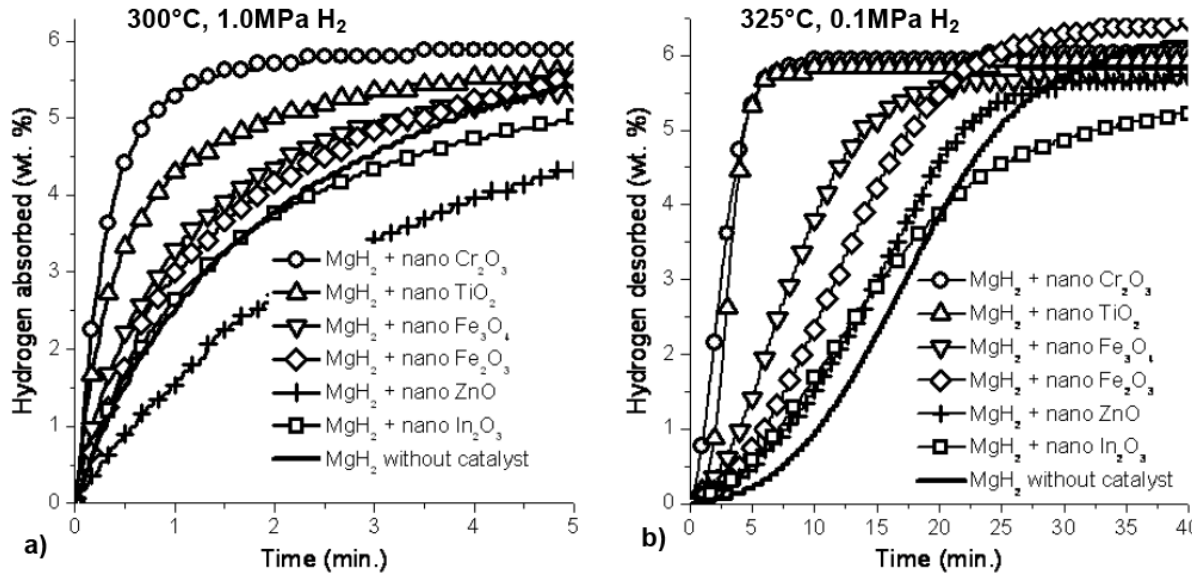
Figure 15. (a) Hydrogen absorption and (b) desorption curves for MgH various nano-sized metal oxides. Adapted from